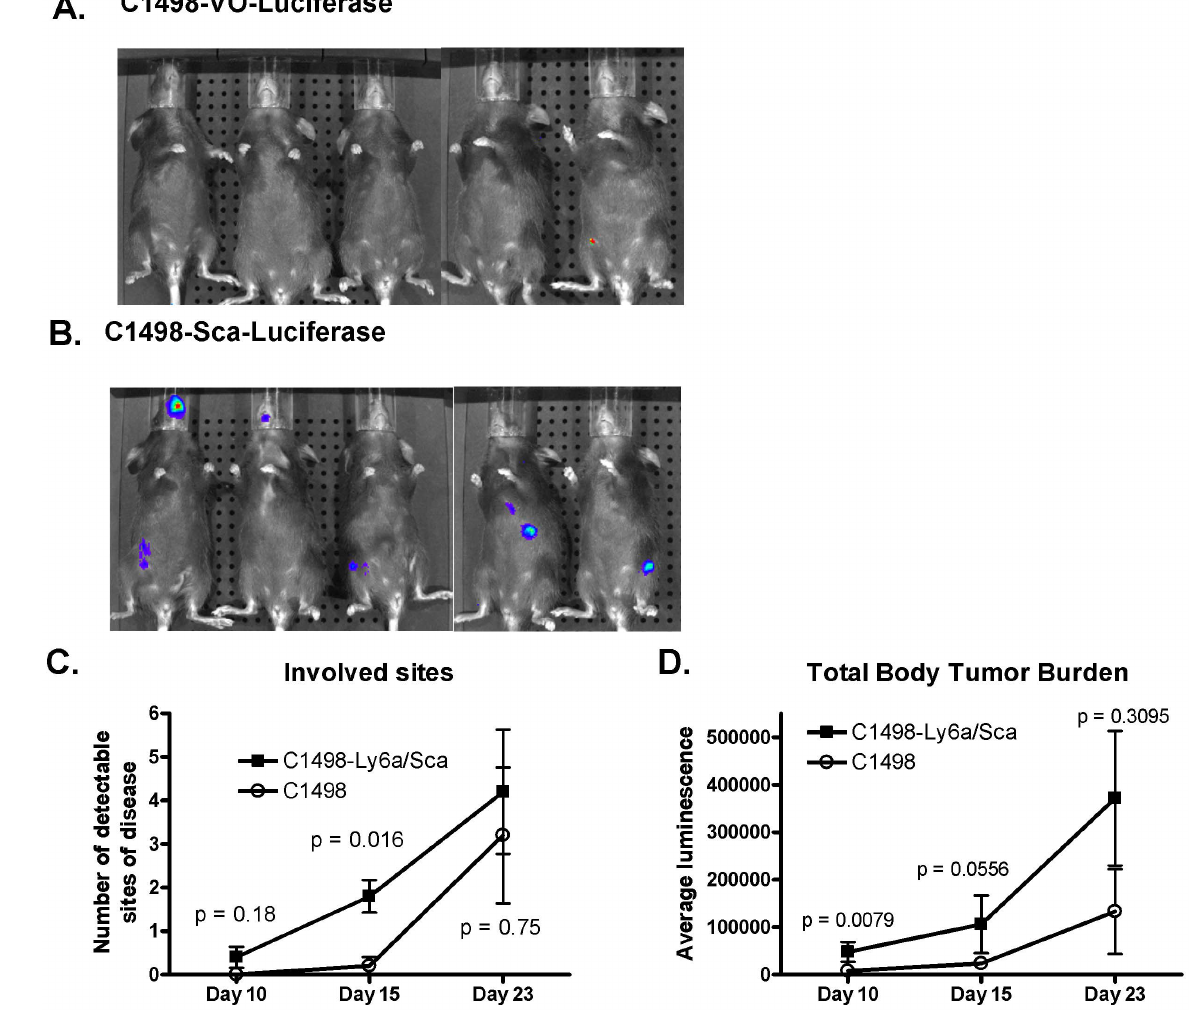
Figure 4. In vivo bioluminescent imaging demonstrates that C1498-Ly6a/Sca-1 disseminates more rapidly and creates greater total leukemia burden than the C1498-vector only control. Normal mice were intravenously injected with leukemia cells (5 6 10 5 ) that had been transduced with a luciferase gene. Animals were imaged on days 10, 15 and 23 after injection. 5 animals in each group. Bioluminescent images at day 15 of (A) C1498-vector only, and (B) C1498-Ly6A/Sca challenged mice. (C) Number of discrete anatomic sites exhibiting luminescence. Animals were imaged and two independent investigators identified the number of discrete sites of luminescence in each animal. Symbols are the average number of sites and bars are standard errors of the mean. P values were calculated with a Wilcoxon test. (D) Total body leukemia burden measured by in vivo bioluminescence. Animals were imaged on days 10, 15 and 23 after intravenous injection with leukemia cells. Total luminescence for entire body was measured in photons/sec. Symbols represent the mean and bars the standard error of the mean. P values were calculated with a Wilcoxon